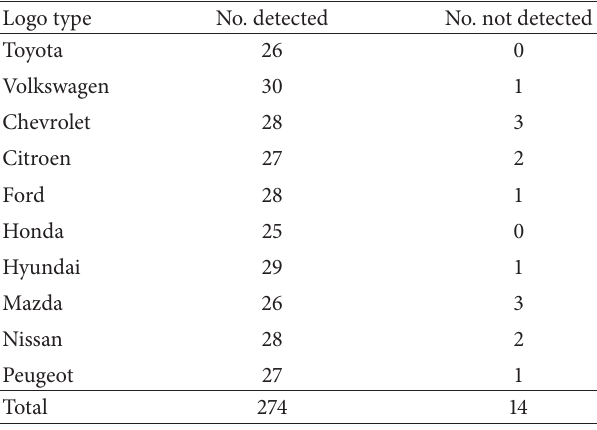
Table 2: Comparison of the detection results for different types of vehicle